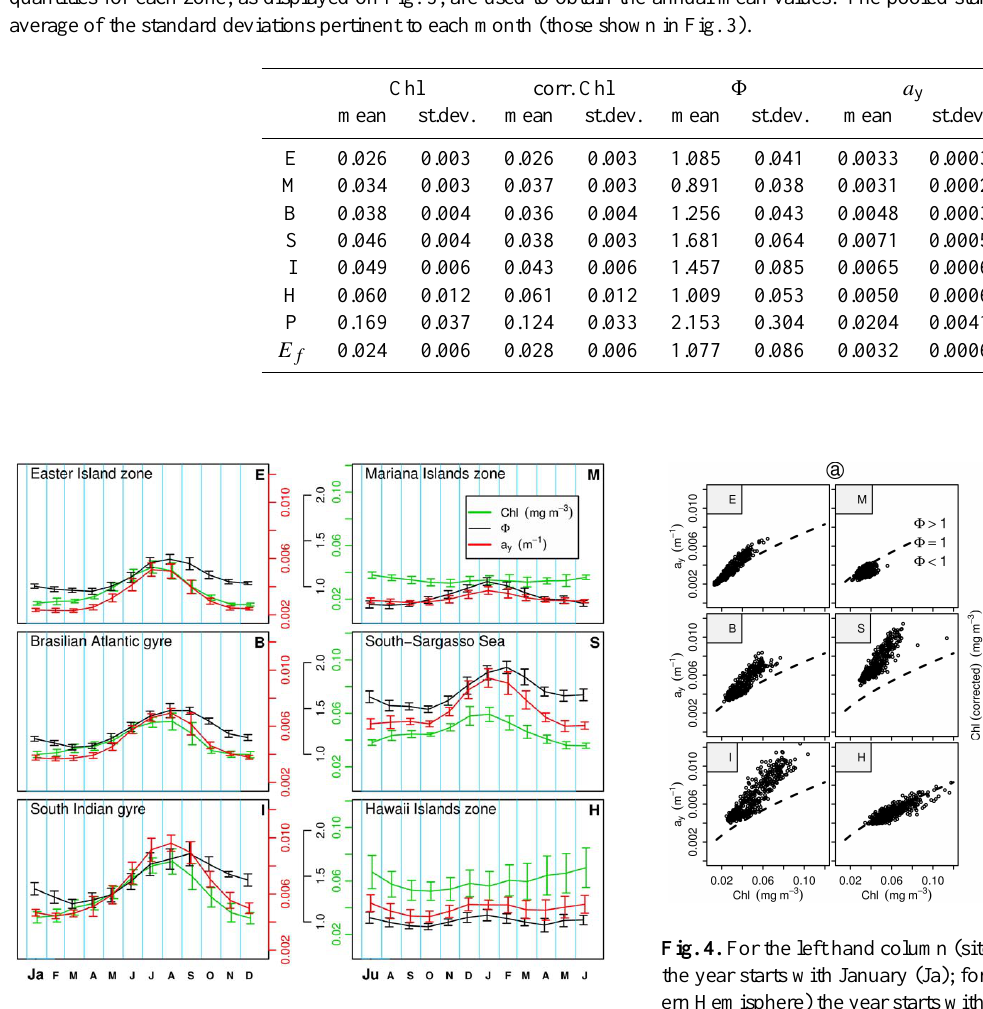
Fig. 3. Climatological annual cycles (temporal resolution: one month) of the three parameters, [Chl], 8 , and a y (443) within each zone; the cycles are obtained by averaging over 10 years the time series displayed in Fig. 2. Same symbols, colors, units, and scales as in Fig. 2. The vertical bars correspond to ± 1 standard deviation computed for each month over the 10y period, and express the year- to-year variability of the monthly mean values inside each zone.